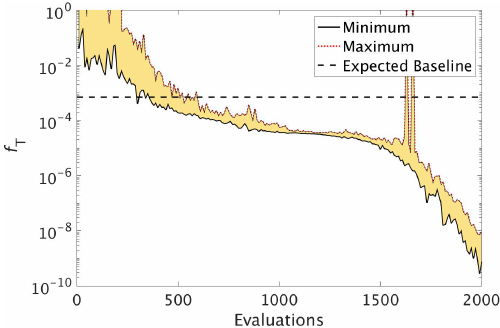
Figure 6. The reduction in global misfit of MOPS to the twin MOPS-ref observations by CMA-ES for the experiment C_SMOOTH. There were 10 MOPS evaluations within each CMA- ES iteration (population λ = 10), ran in parallel. Plotted is the base- line (horizontal black dashed line), minimum (black solid line) and maximum (red dotted line) misfit of each population, with the area between shaded